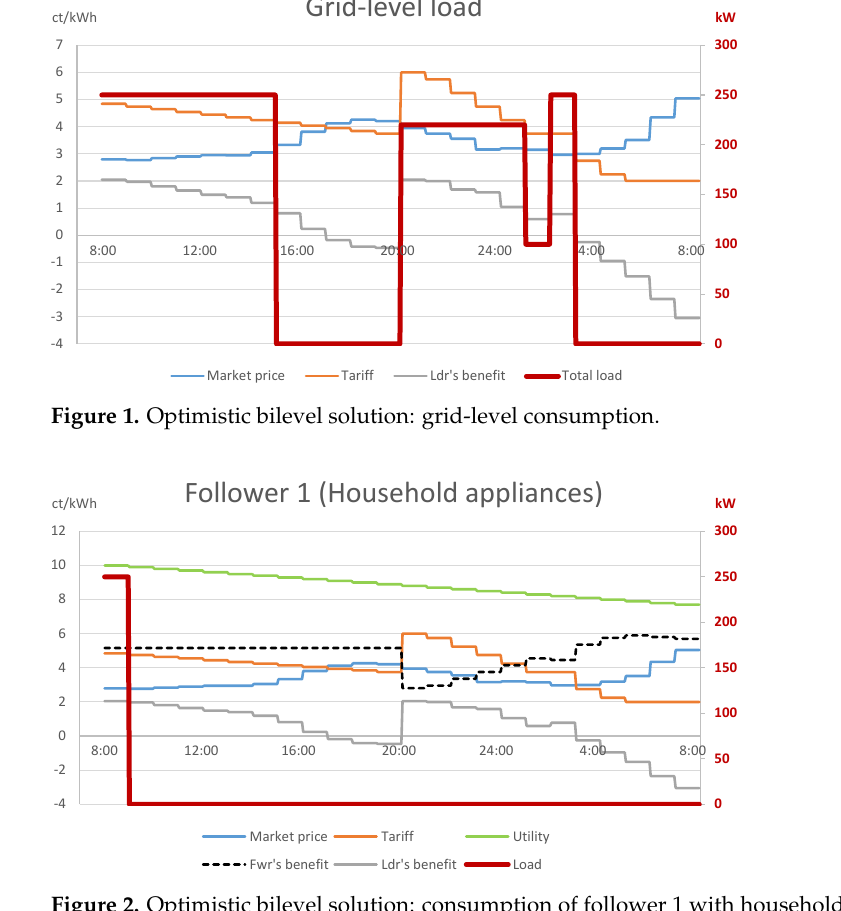
Figure 2. Optimistic bilevel solution: consumption of follower 1 with household appliances.